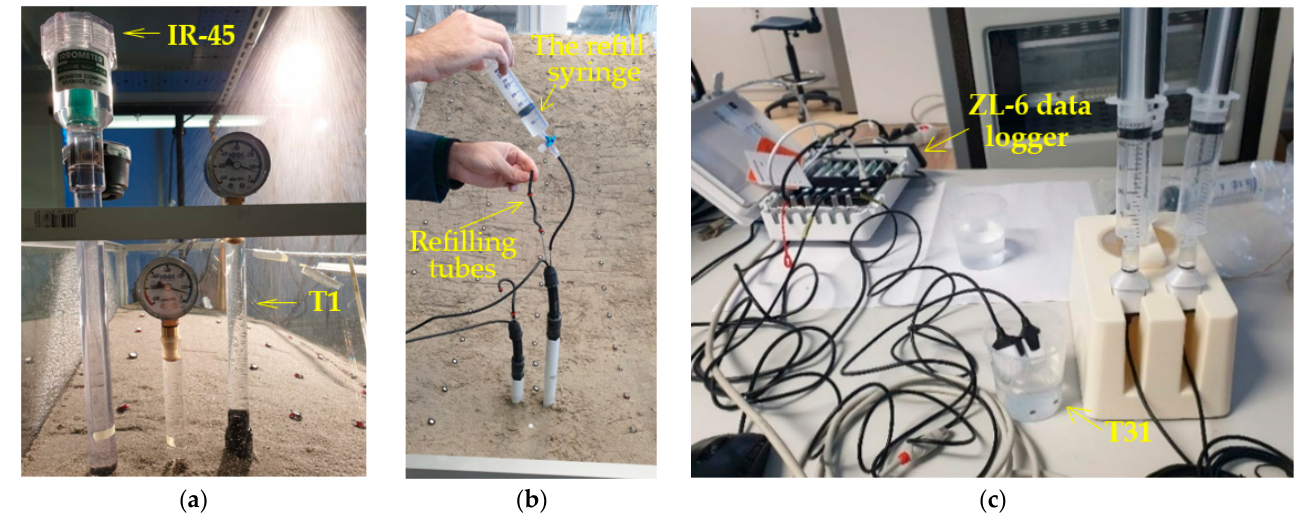
Figure 6. Standard, non-digitalized IR and T1 tensiometers in tests on clean sand ( a ); preconditioning of TEROS 32 ( b ); and TEROS 31 tensiometers ( c ).